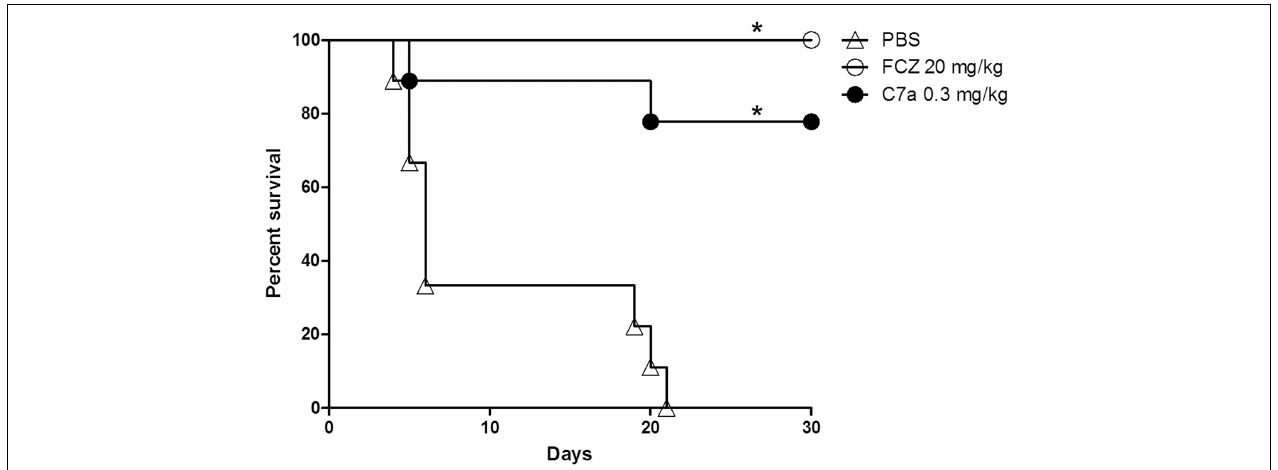
FIGURE 5 | Survival of immunosuppressed mice with disseminated candidiasis treated with C7a or FCZ. Previously immunosuppressed animals were intravenously infected with 10 4 yeasts of C. albicans ATCC 10231. The animals ( n = 10/group) were intraperitoneally treated with PBS, 0.3 mg/kg of C7a or 20 mg/kg of FCZ every 24 h for 7 days. Animal survival was observed for 30 days after infection. ∗ Indicates statistical significance compared to PBS-inoculated group (Long-rank test, P < 0.05). One representative experiment out of 3 is showed.